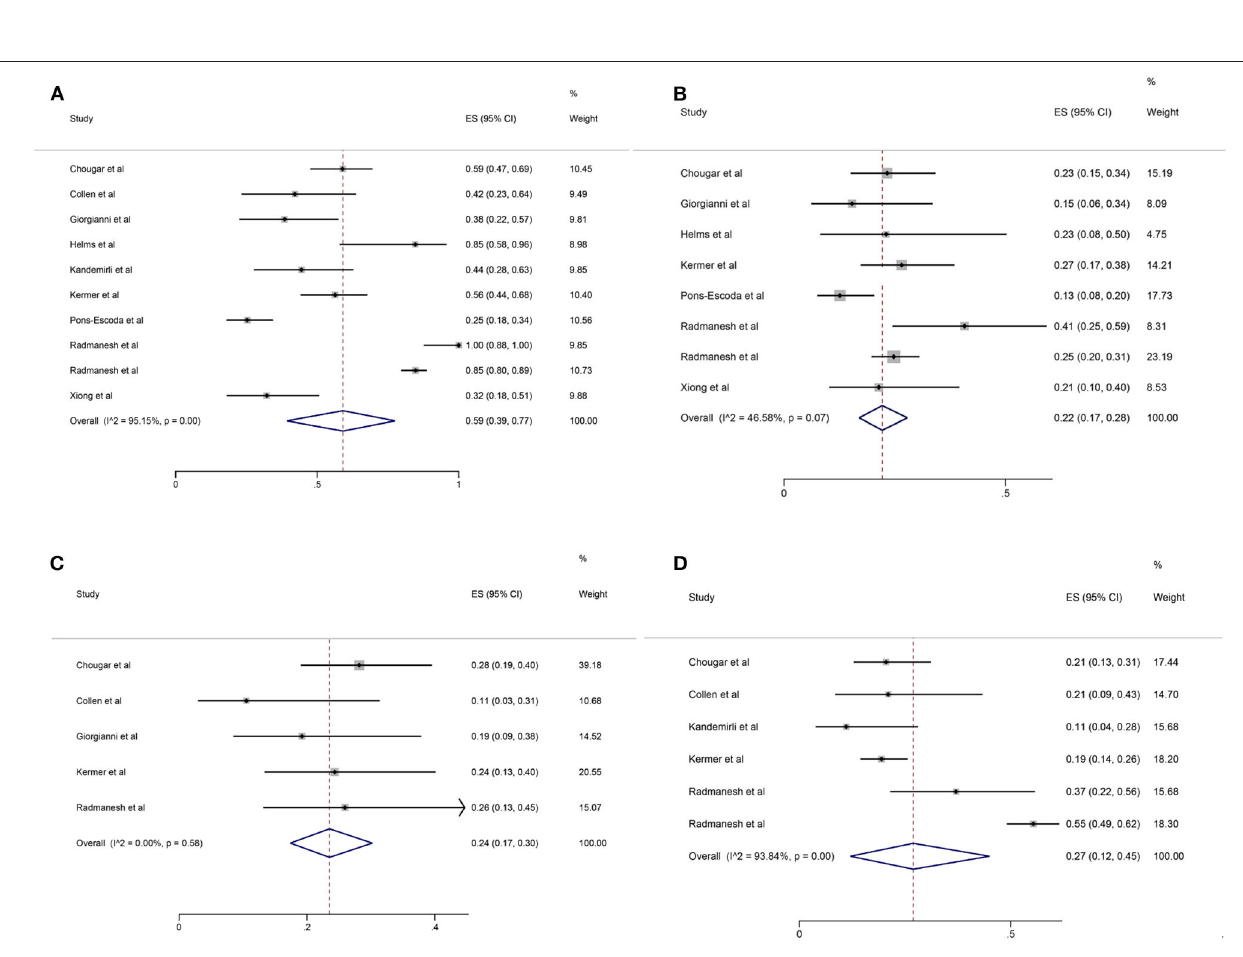
Frontiers in Neurology |